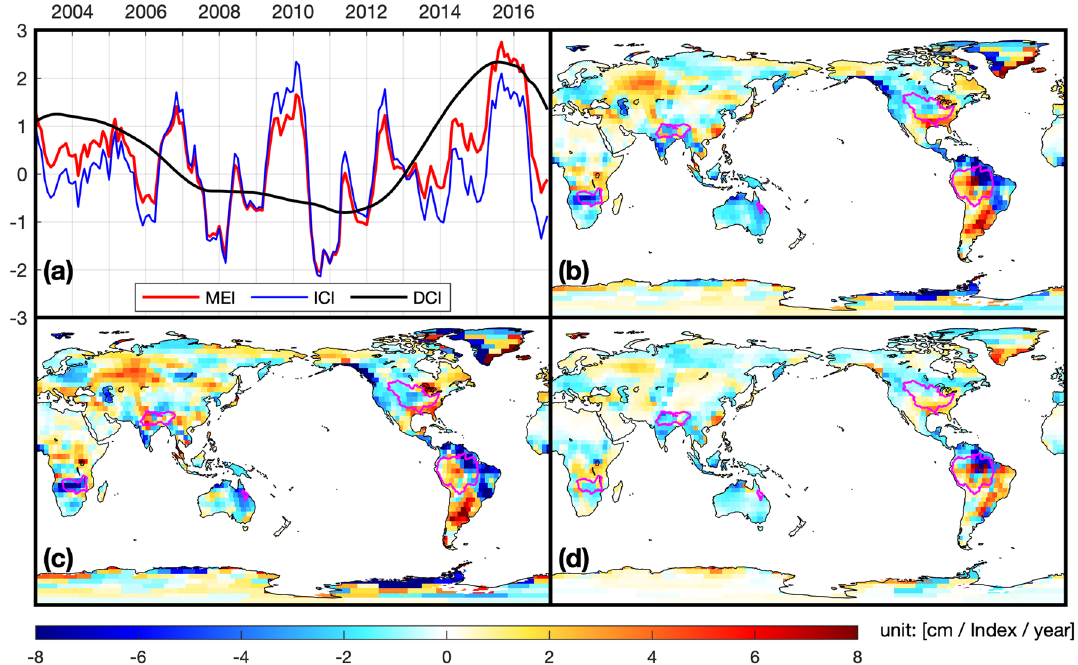
Figure 1. ( a ) ENSO Indices (MEI, DCI, and ICI; normalized by each standard deviation); the spatial map of influence of ( b ) MEI, ( c ) DCI, and ( d ) ICI from the LSR analysis (( b ) original LSR; ( c,d ) modified LSR); the magenta-colored lines on the maps are five river-basins. The graph and maps were created using MATLAB (version R2020b; https:// www. mathw orks. com/ produ cts/ matlab.